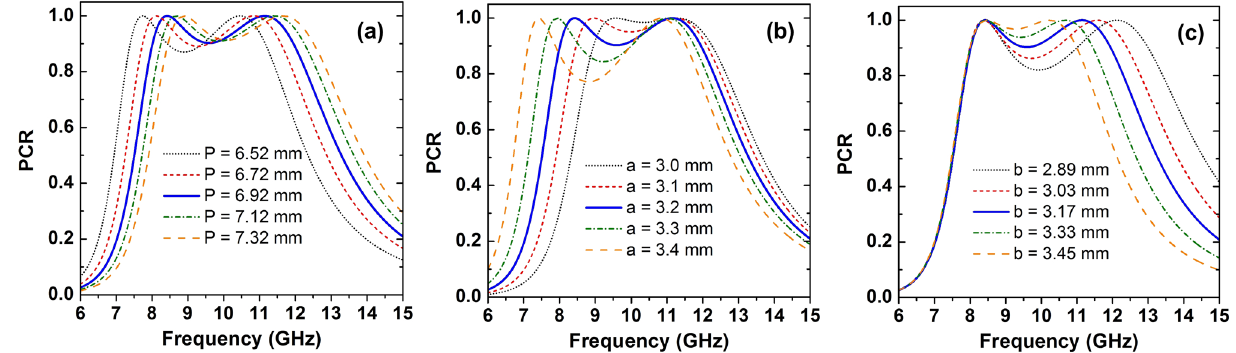
Figure 8. The variation of PCR with various unit cell parameters of the proposed polarization converter: ( a ) P , ( b ) a , and ( c ) b